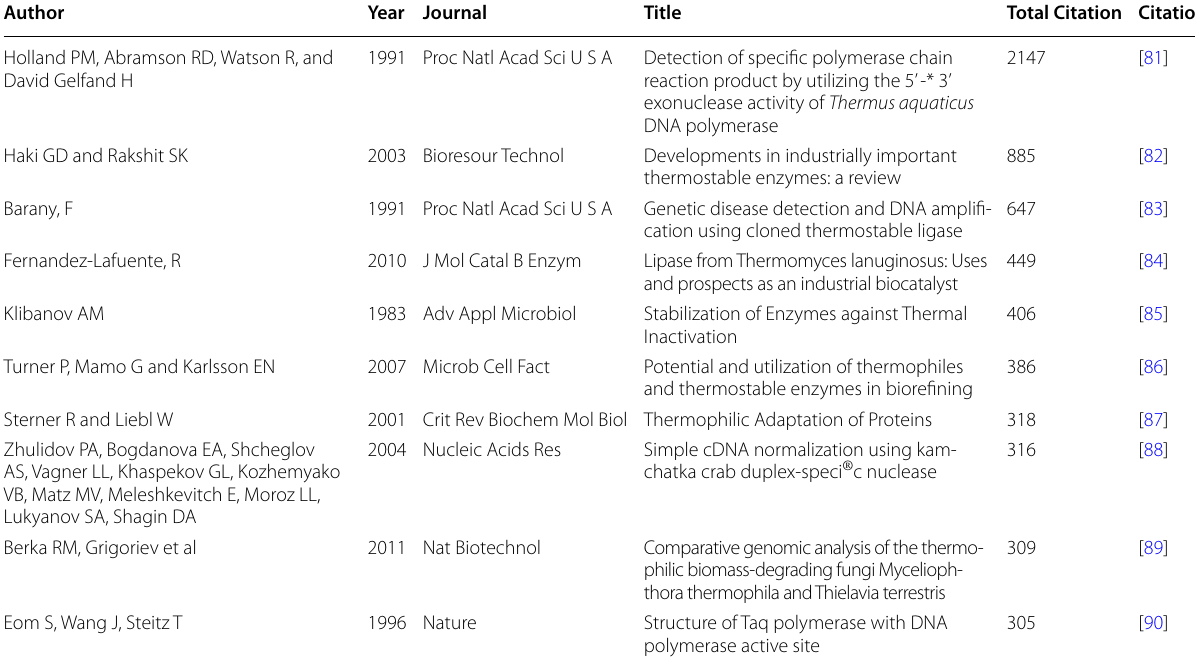
Table 1 Top 10 most cited publications on thermostable lipase in the Scopus database (1970–2022)